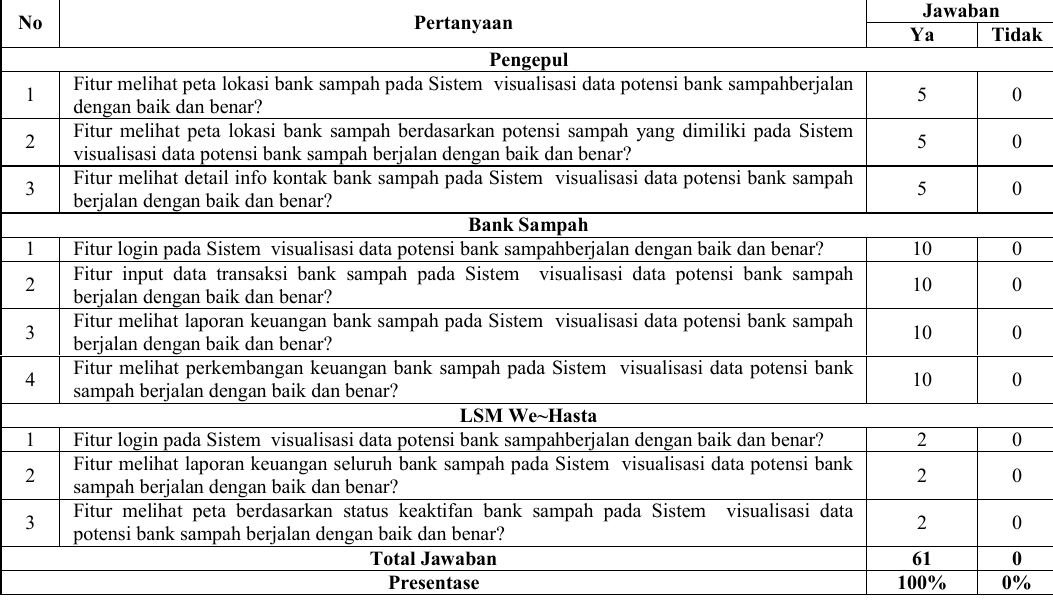
TABEL 2. HASIL PENGISIAN KUISIONER BAGIAN